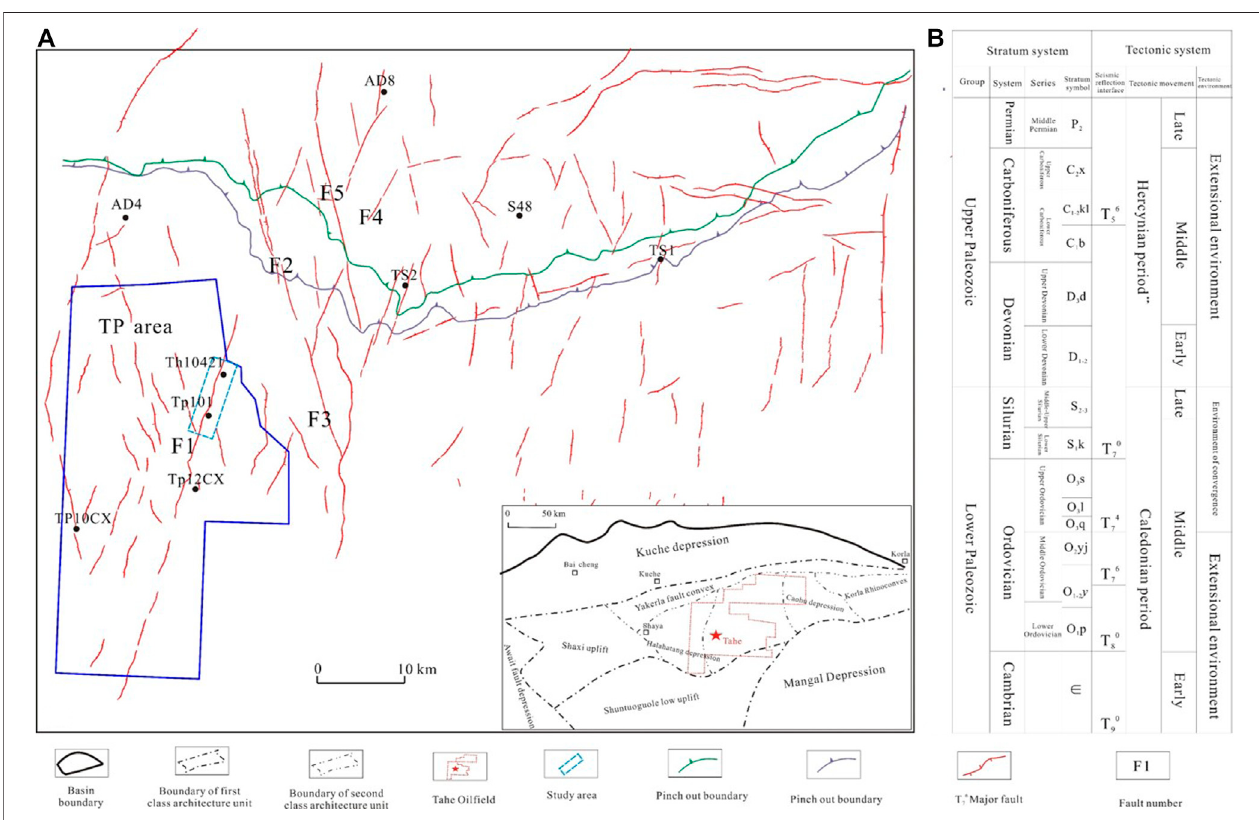
FIGURE 1 | Location of study area and comprehensive stratigraphic column. P2 — Middle Permian; C 2 x — Upper Carboniferous Xiaohaizi Formation; C 1 kl — Lower Carboniferous Karasayi Formation;